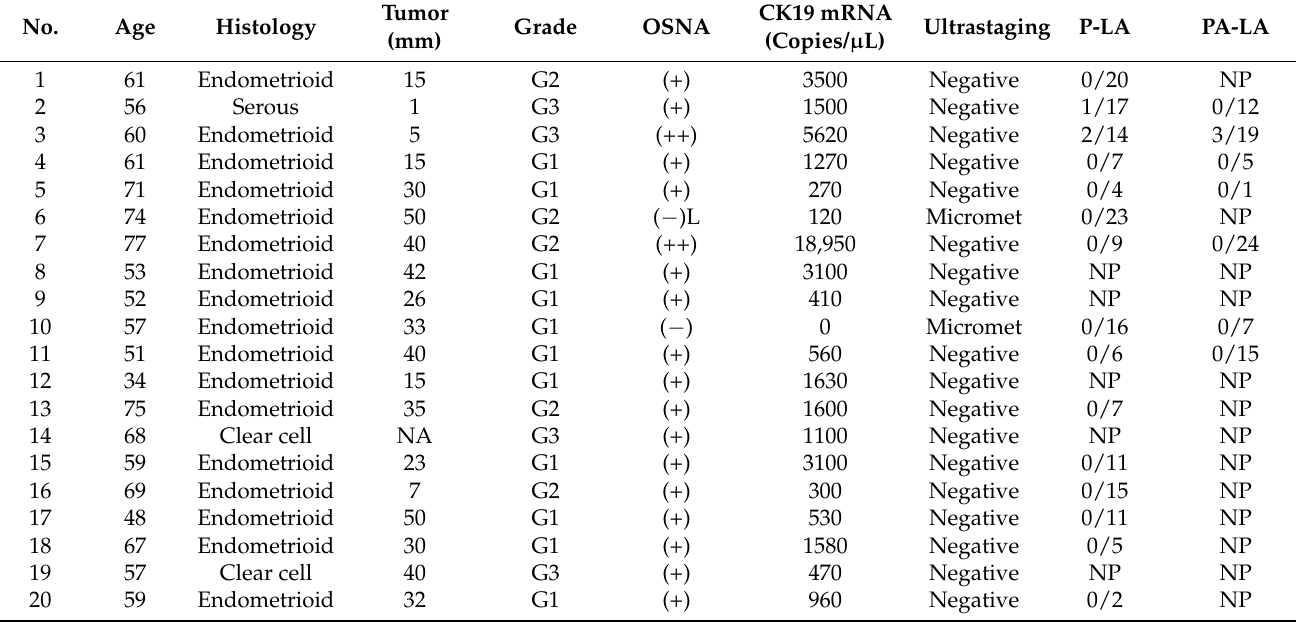
Table 3. Consistency between pathological ultrastaging analysis and OSNA. Table 4. Summary of discordant cases between the OSNA assay and pathological